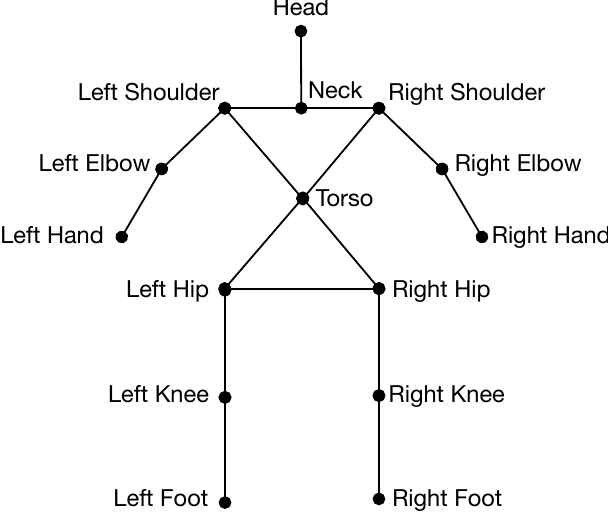
Figure 3. OpenNI’s kinematic model of the human body —OpenNI (NI stands for Natural Interaction) algorithms are able to create and track a kinematic model of the human